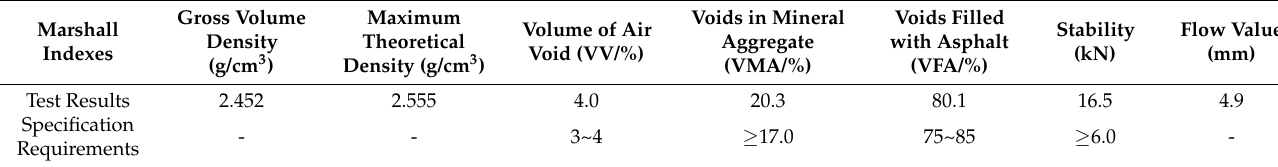
Table 4. SMA-10 Marshall specimen test results.